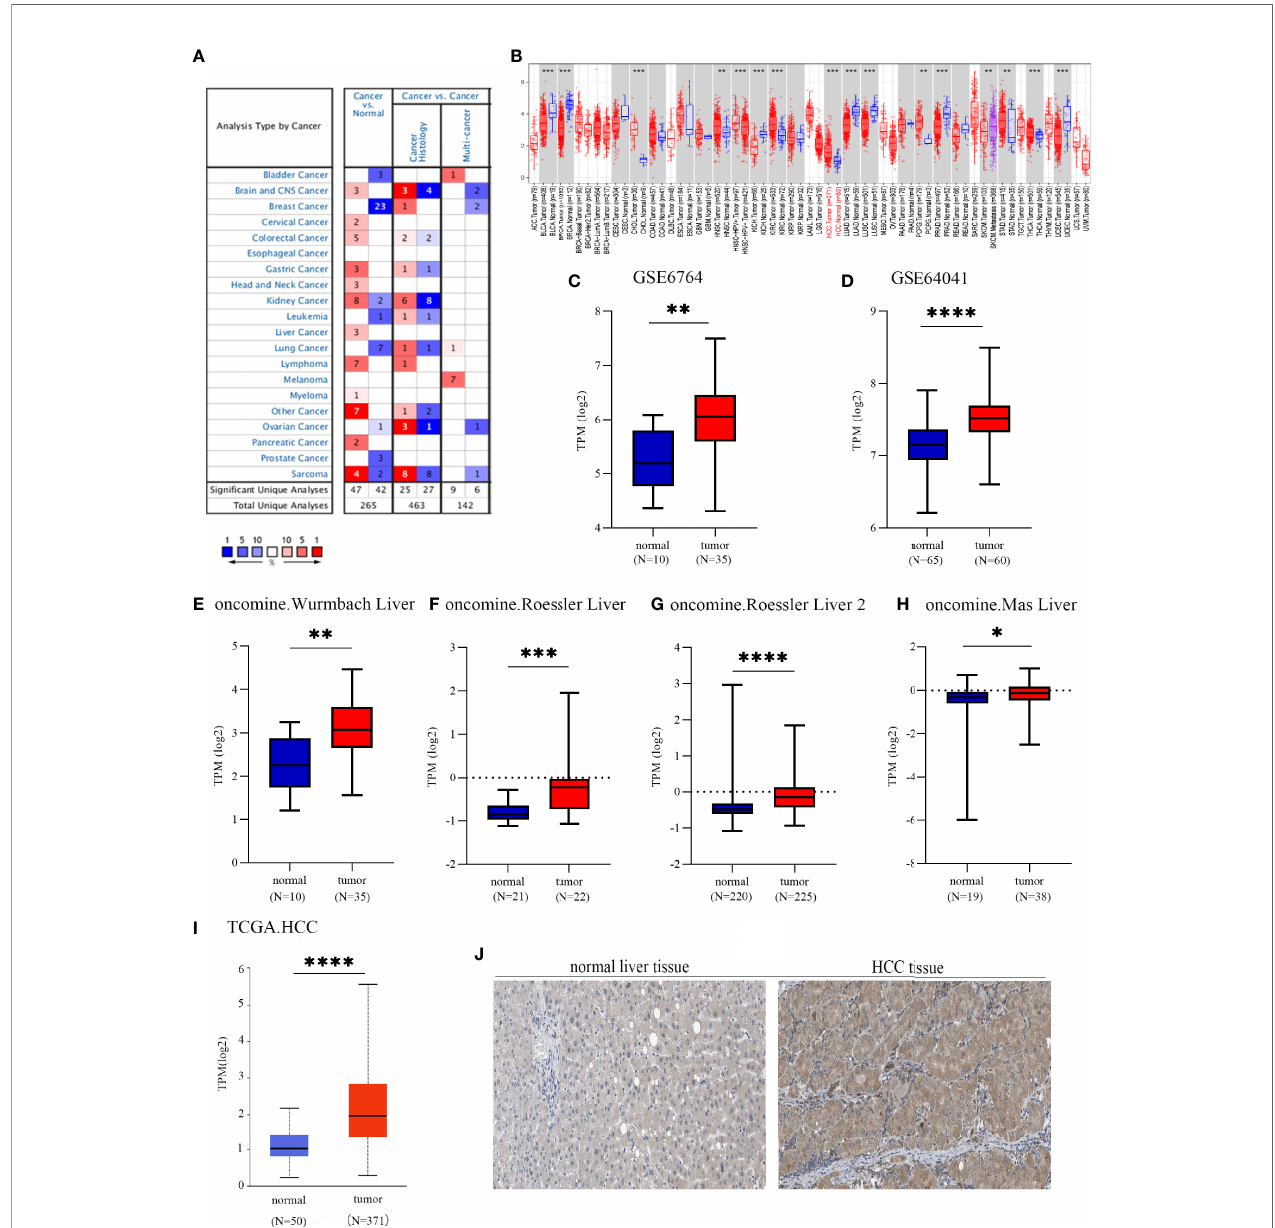
FIGURE 1 | EGF domain-speci fi c O-linked N-acetylglucosamine transferase (EOGT) expression in different types of tumor tissues and normal tissues. (A) RNA expression levels of EOGT in different types of tumor tissues and normal tissues in the Oncomine database ( P -value < 0.01, fold change < 1.5, and gene ranking of all). (B) RNA expression levels of EOGT in different types of tumor tissues and normal tissues in the TIMER database. GEO database series including GSE6764 (C) and GSE64041 (D) and the Oncomine database sets including the Wurmbach liver (E) , Roessler liver (F) , Roessler liver 2 (G) , and Mas liver (H) . (I) RNA expression levels of EOGT between tumor and normal tissues in hepatocellular carcinoma (HCC) samples on the TCGA database. (J) Immunohistochemical staining of EOGT in normal liver tissues and HCC tissues (* P < 0.05, ** P < 0.01, *** P < 0.001, **** P <